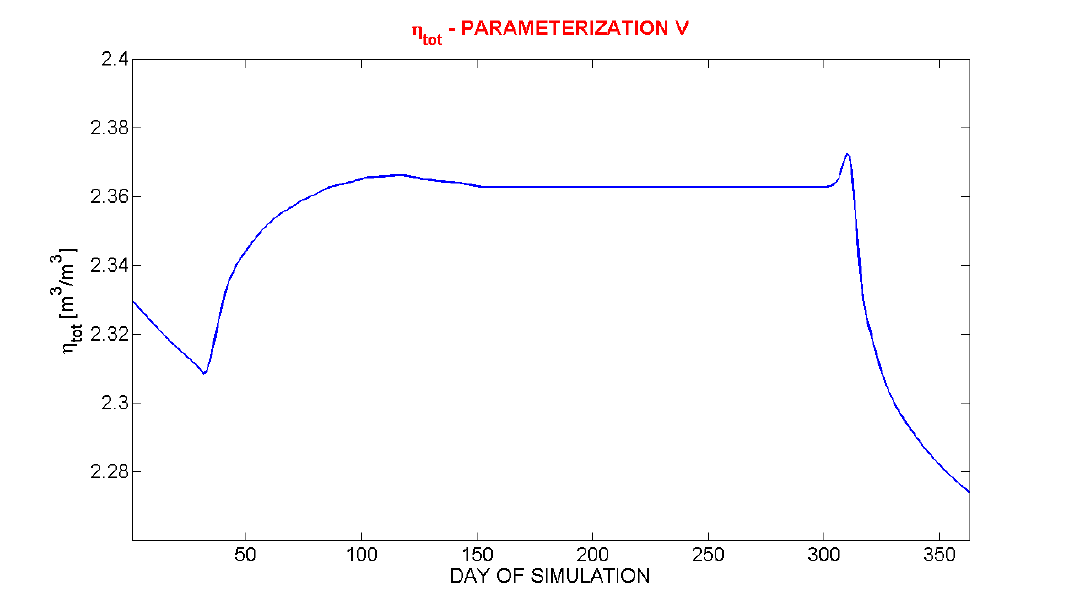
trend for the simulation with synthetic Figure 8. η tot